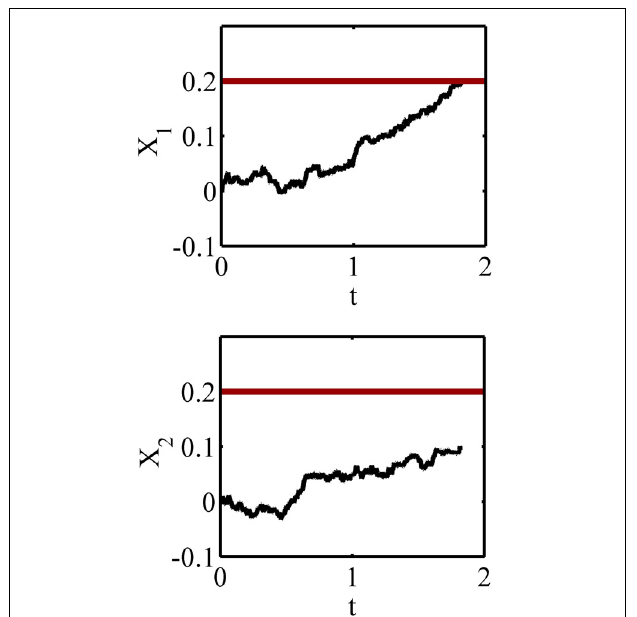
FIGURE 2 | A sample path of the accumulated information in the two accumulators of the race model. The black paths are the accumulated information and the thick red lines are the decision thresholds. The accumulated information in the accumulator 1 reaches the decision threshold at about 1.8s and before the accumulator 2 and so the response 1 will be selected.